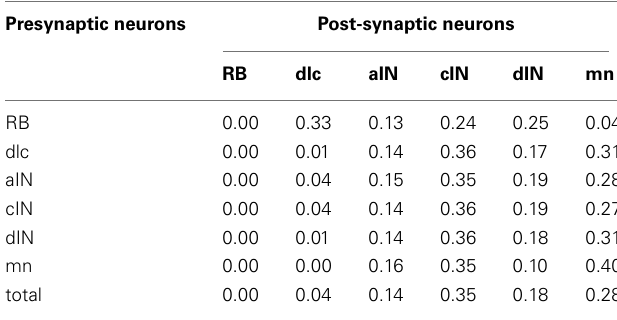
Table 3 | Probabilities of connections between all types of presynaptic neurons and all post-synaptic neurons in the